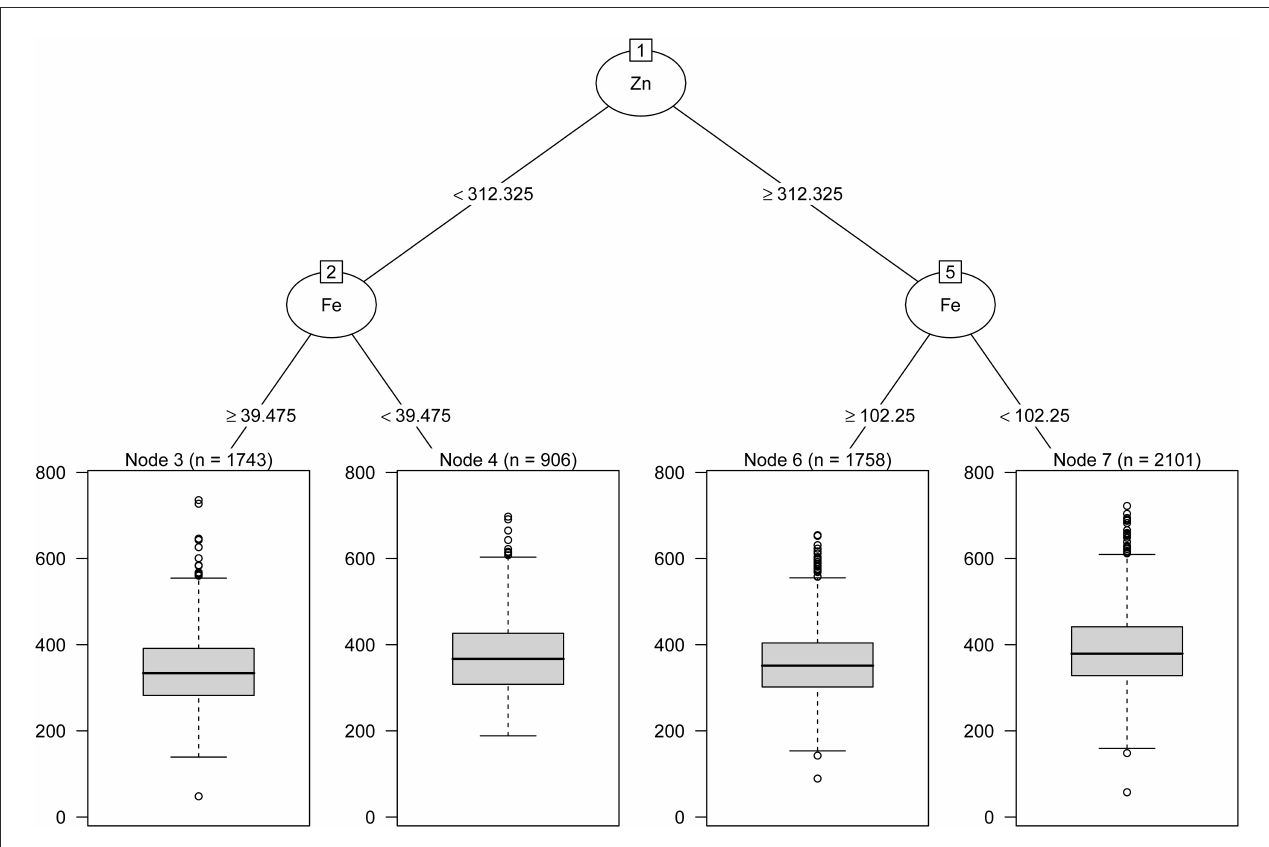
FIGURE4 Combined associations between urinary metal levels and SUA concentrations performed with regression tree.